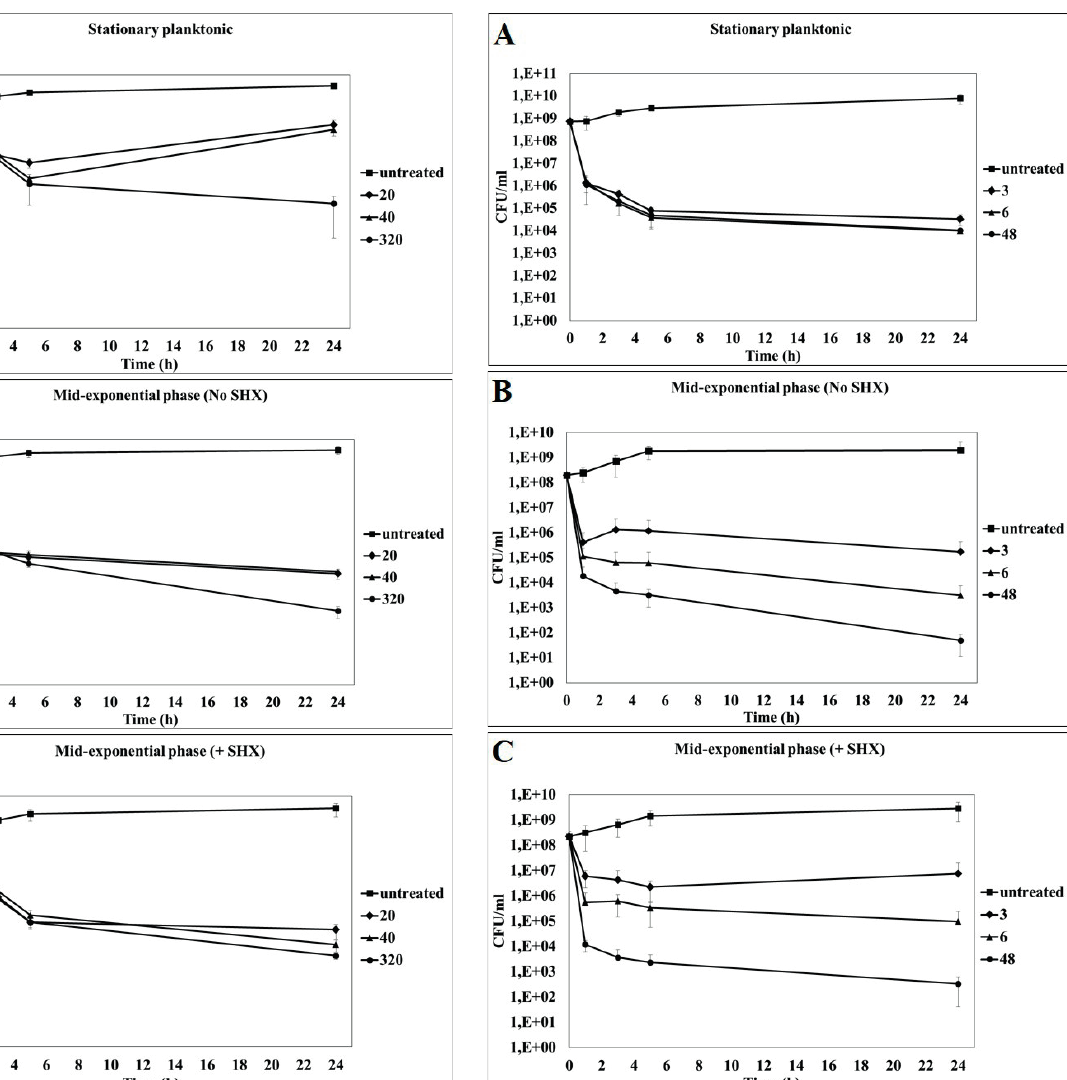
Fig. 4. Killing of P. aeruginosa PAO1 wild-type cells by poly- myxin B. Cells of stationary-phase (A), exponential-phase without SHX (B) and exponential-phase cultures with SHX (C) were exposed to 4-, 8- and 64-μg/mL of polymyxin B (MIC is 0.8 μg/mL) for 1, 3, 5 and 24 h and then plated for colony forming units (CFU/ mL). The percent survival is not shown. The values are averages of three independent experimetns and error bars are not shown, and the error bars indicate the standard error of the mean.